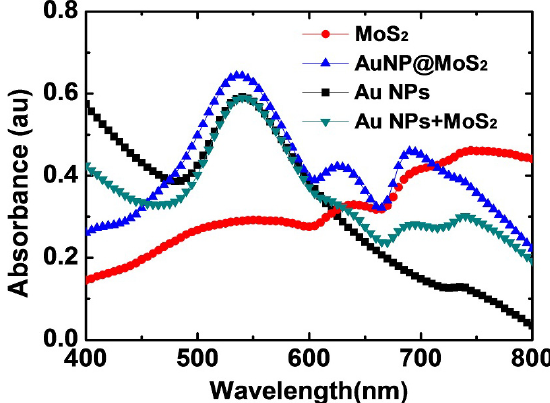
Figure 1. Absorption spectra of the nanocomposites dispersed in aqueous